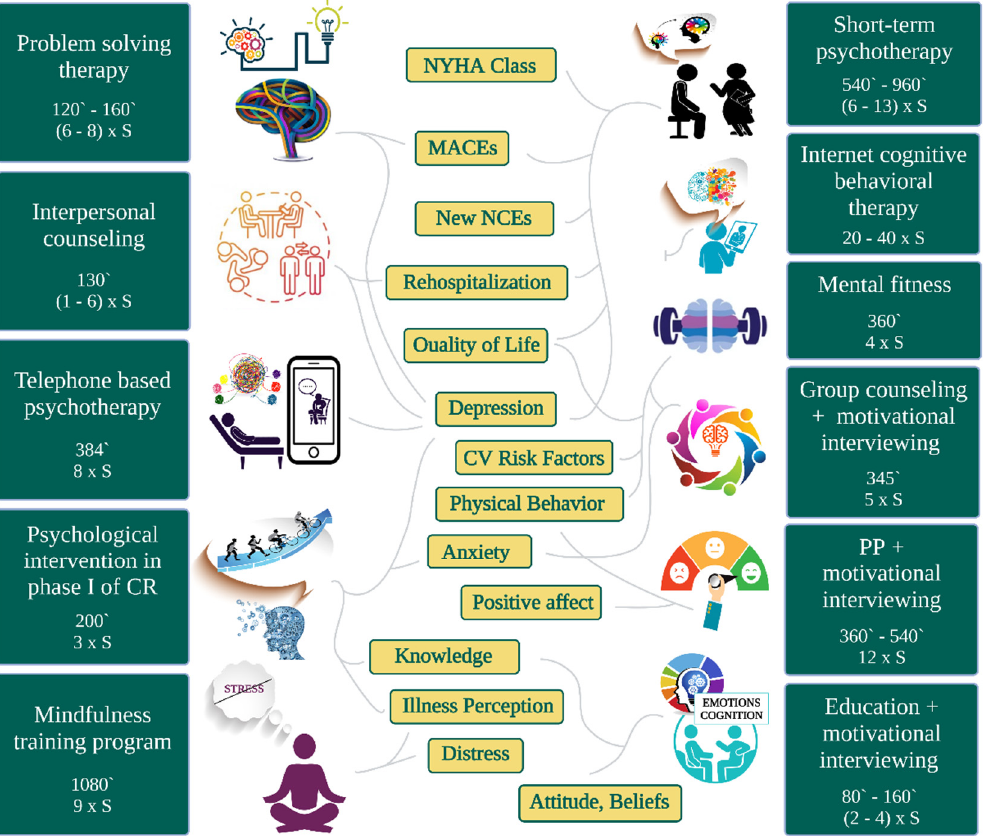
Figure 3. The benefits of psychoeducational interventions specific to the type of cardiac rehabilitation programs and their total dose expressed in number of sessions (S) and minutes (‘). CR = cardiac rehabilitation, PP = positive psychology, NCEs = non-cardiovascular events.